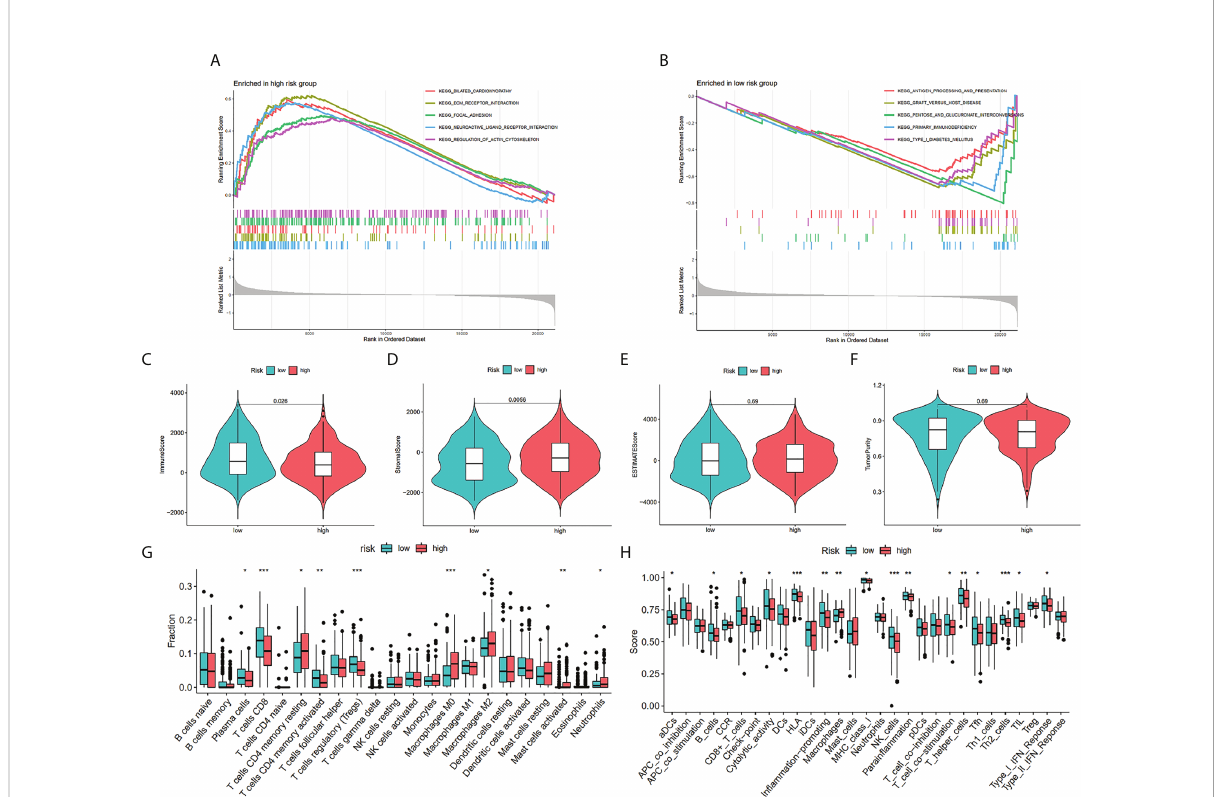
FIGURE 7 Enrichment analysis and immune estimation in high- and low-risk groups. Enrichment plots from gene set enrichment analysis in the high-risk group (A) and low-risk group (B) according to risk score based on TILRGs. Immune score (C) . Stromal score (D) . ESTIMATE score (E) . Tumor purity (F) . The fraction of 22 immune cells in low- and high-risk groups calculated by CIBERSORT algorithm (G) . The fraction of immune cells and immune function in low- and high-risk groups calculated by ssGSEA algorithm (H) . * P < 0.05, ** P < 0.01, and *** P <